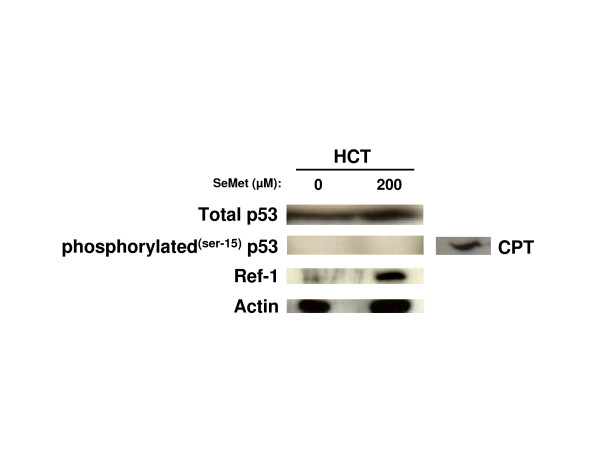
Selenomethionine treatment does not result in great levels of expressed or activated p53. HCT 116 cells were not treated or treated with selenomethionine (200 μM) for 24 hours prior to protein isolation. Western blot analysis reveals that expression of wild-type p53 is unchanged in the presence of selenomethionine; activation of p53 by serine-15 phosphorylation does not occur in the presence of selenomethionine; p53 is phosphorylated at serine-15 when cells are treated with camptothecin (CPT; 30 nM) for 24 hours; it serves here as a positive control.